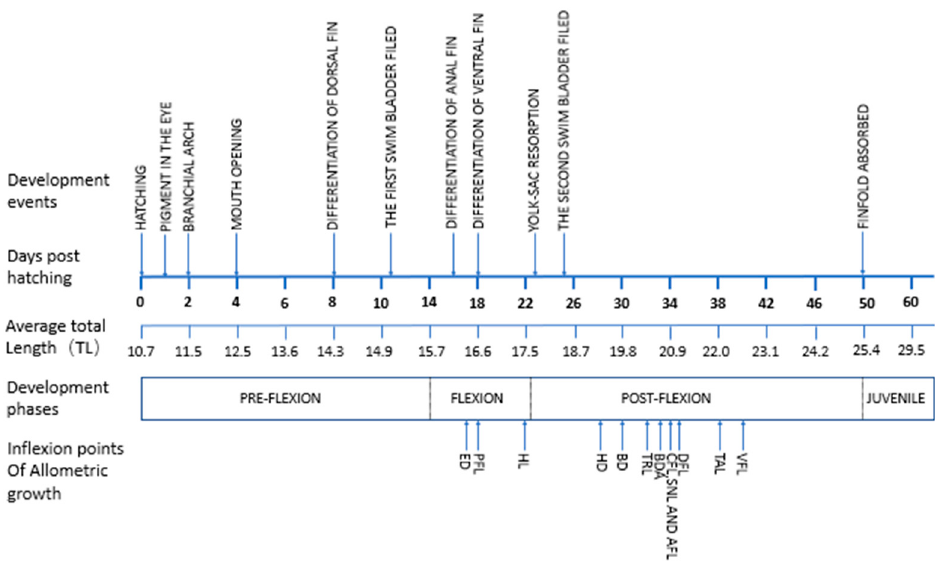
Figure 4. Major growth events of S. waltoni during larval and juvenile periods. AFL, anal fin length;